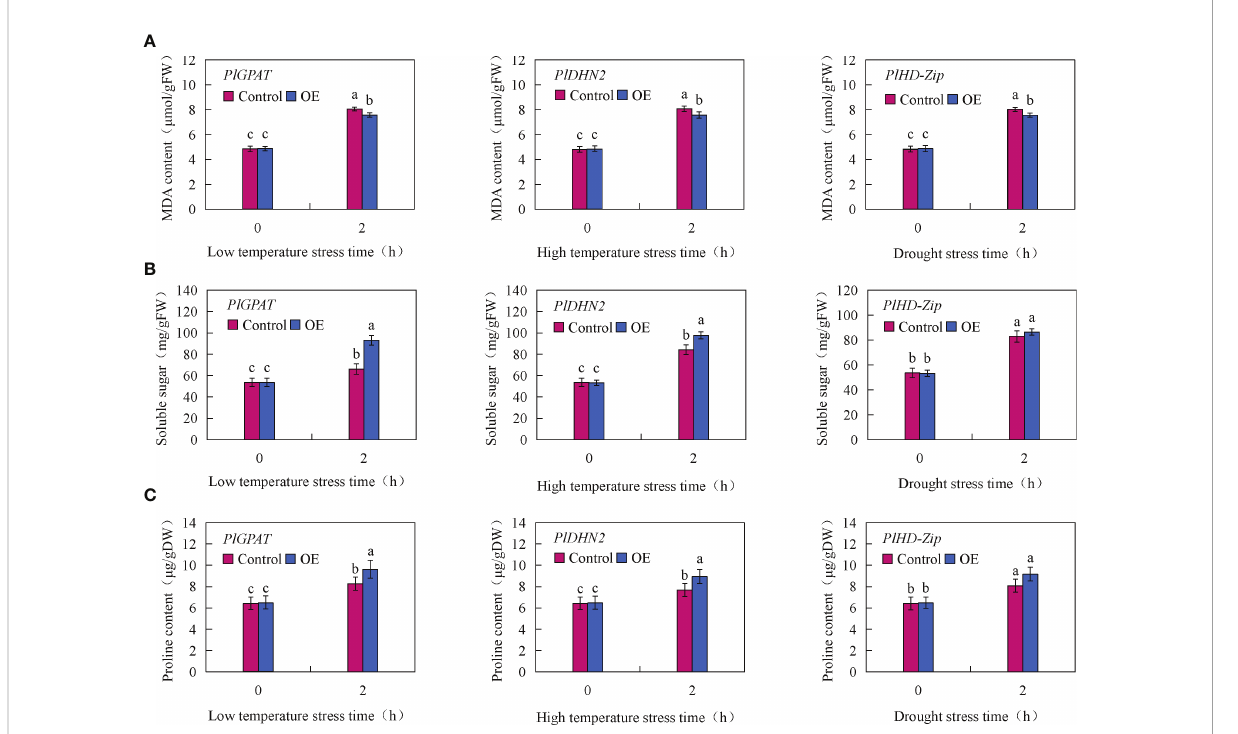
FIGURE 8 Analysis of Physiological index in P. lacti fl ora seedlings with transient overexpression of stress resistance genes. (A) MDA content. (B) soluble sugar content. (C) Proline content. Error bars indicate standard deviation of three replicates. Different letters mean signi fi cantly different by Duncan ’ s multiple range test at P <